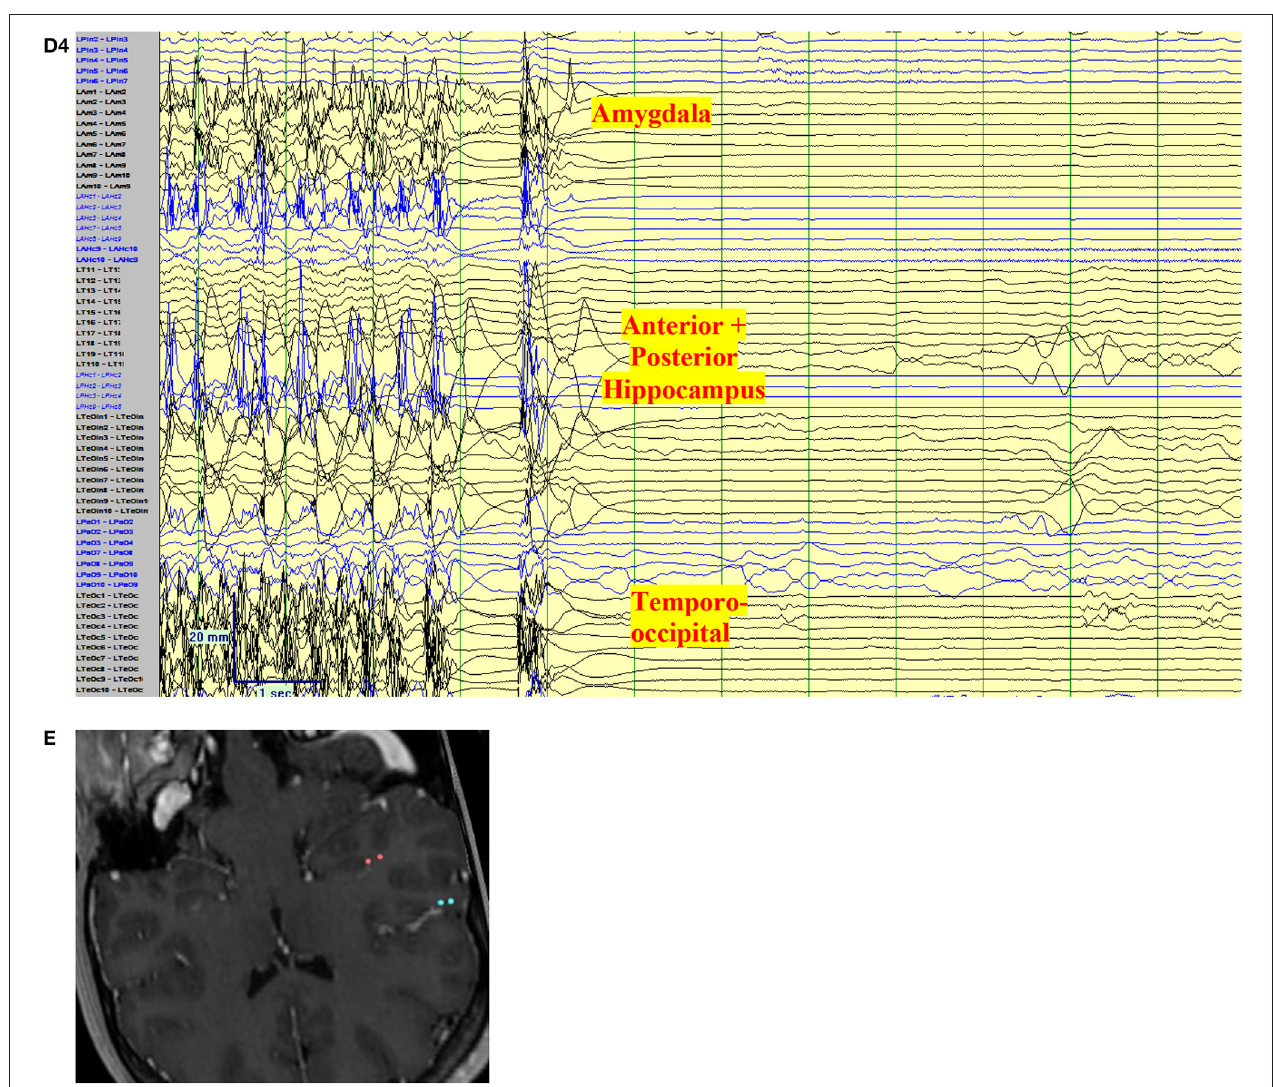
FIGURE 3 | Clinical vignette. A 24-year-old left-handed female, like her father, began with epilepsy at age 15. Semiology began as a non-specific abdominal sensation, loss of awareness, speaking “gibberish”, or changing subjects of conversations. The seizures were often associated with lacrimation, salivation, and chewing automatisms with a frequency of 2 seizures per month. There was no tendency to progress to bilateral tonic-clonic. She has tried more than 7 antiseizure medications. Interictal Scalp encephalography (EEG) findings in Epilepsy Monitoring Unit admissions were unremarkable with no interictal discharges with the exception of rare left posterior temporal polyspikes during sleep (T5 spreading to O1-T3). Ictal Scalp EEG showed onset over the same area, but the scalp EEG changes did not precede clinical manifestations by more than 30s. MRI Brain, was unremarkable, positron emission tomography (PET) CT showed no definite quantitative or qualitative hypometabolic focus. SPECT showed no clear focal area of hyperperfusion but showed a non-specific increase in perfusion in the left temporoparietal region. The neuropsychological evaluation showed left-hemispheric language dominance and mild memory impairment. The case was presented to a multidisciplinary team and stereo-encephalography (SEEG) implantation was decided. Limbic coverage with an emphasis on the temporo-parietal occipital junction (due to the EEG, SPECT, neuropsychological findings) and the opercular-insular region (because of clinical findings) was decided. After presurgical investigations were completed, resective surgery was not decided due to the risk of global aphasia. (A) Trajectory planning of SEEG electrode insertion with Renishaw Neuroinspire TM software, co-registered with MRI. (Image courtesy of Dr. David Steven and Dr. Greydon Gilmore, London Health Sciences Centre, London, Ontario, Canada). (B) Insertion of Depth electrodes by Renishaw Neuro-Mate. Neurosurgeon and robot assisting device when installing depth electrodes in the operating room. (Image courtesy of Dr. David Steven and Dr. Greydon Gilmore, London Health Sciences Centre, London, Ontario, Canada). (C) Interictal SEEG: Longitudinal bipolar montage of intracranial SEEG recording with a sampling rate of 1,280, showing synchronized spikes seen as runs lasting up to 4s at a time involving the neocortical temporal, temporo-occipital, and parietal-occipital region. Synchronic interictal findings are a frequent finding of temporal lobe epilepsy and its connections. (D) Ictal SEEG: (D1) Longitudinal bipolar montage of intracranial SEEG recording with a sampling rate of 1,280, showing an attenuation of the background activity, with low voltage fast activity in the same regions of synchronization seen in A for 5-6s. (D2) Previously seen attenuation is followed by a high-voltage spike that runs over the mesial temporal regions. (D3) As the seizure propagates, the activity spreads to the neocortical temporal regions. (D4) Periods of attenuation occur until the final offset is seen as attenuation. (E) Cortical stimulation showed a wide hyperexcitable epileptogenic network involving the parieto-temporo-occipital region, both mesial and neocortical. When stimulating the left mesial temporal region, anomia occurred (pink color in co-registered MRI) and when stimulating the neocortical temporo-occipital region, speech arrest occurred.